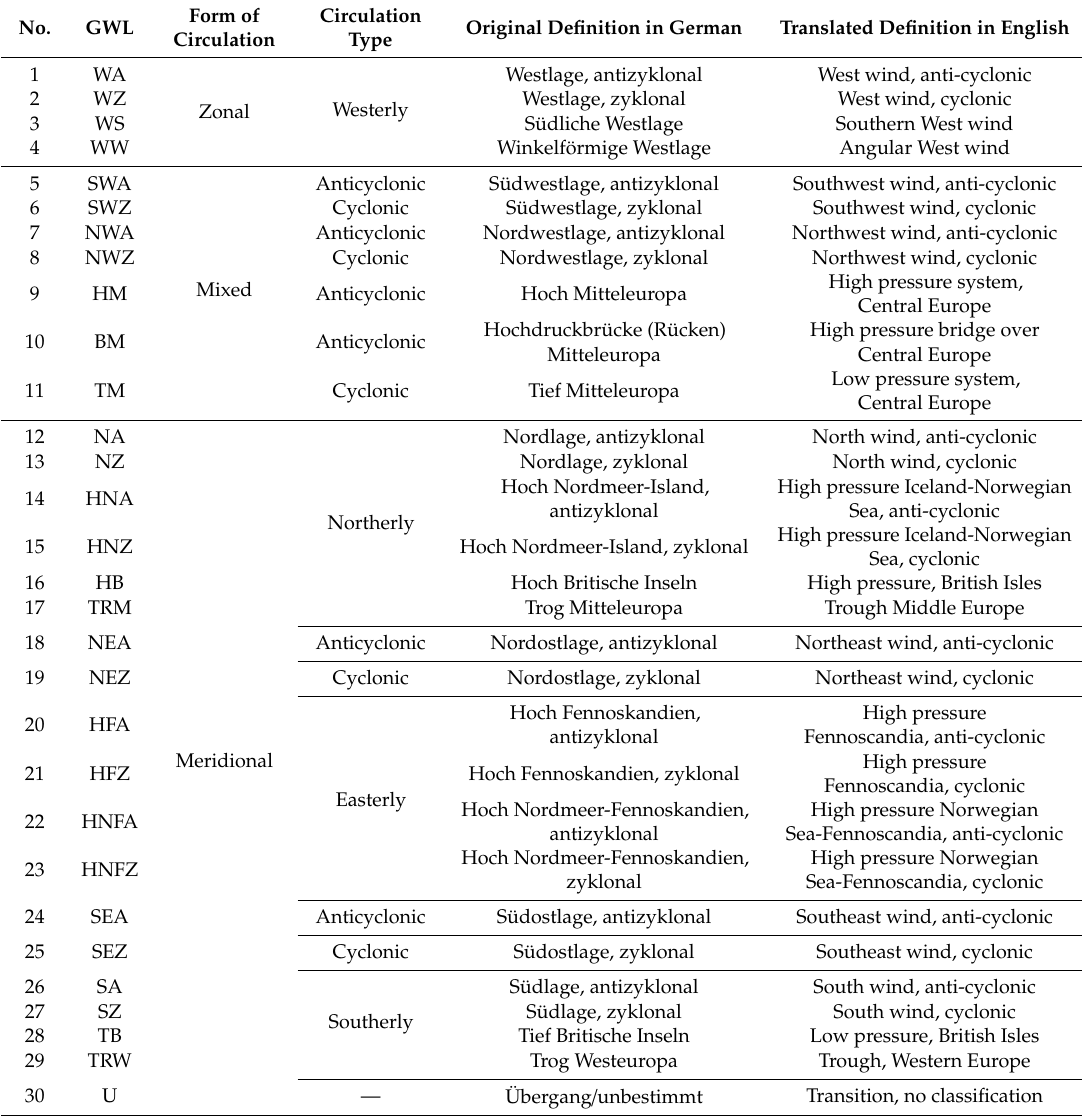
Table 1. Classification, definition, and associated circulation patterns (CPs) of Hess and Brezowsky Großwetterlagen (HB-GWL) catalog (adapted from Hess and Brezowsky [40]).